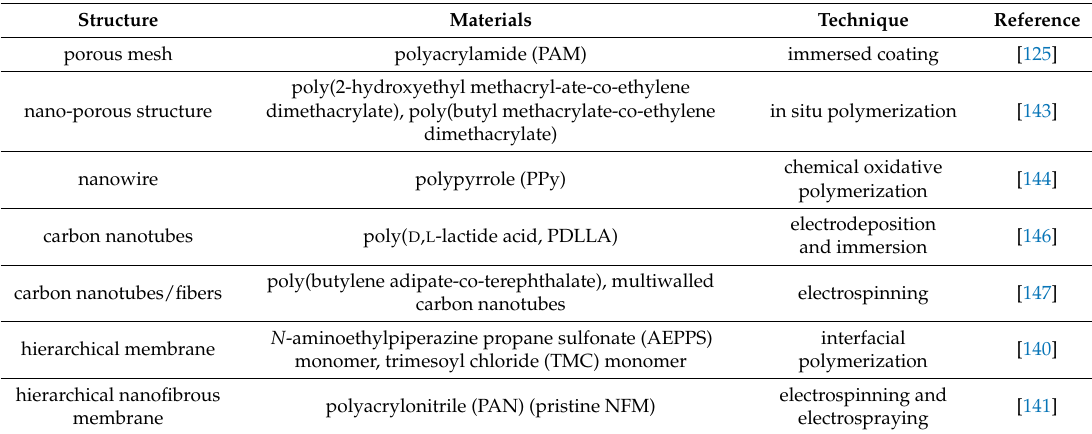
Table 1. List of bio-inspired structures, materials, and surface modification techniques for the fabrication of bio-mimicked superhydrophilic